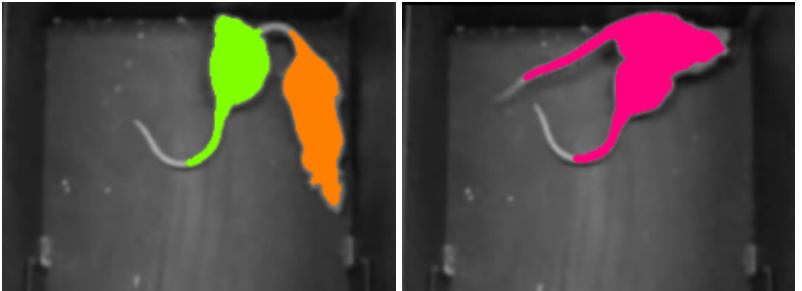
Figure 3. ToxTrac, which requires no preliminary annotation, was applied on our test sequences. Non-occlusion instances are usually well detected, but instances are not separated during occlusions: a single mask is provided.